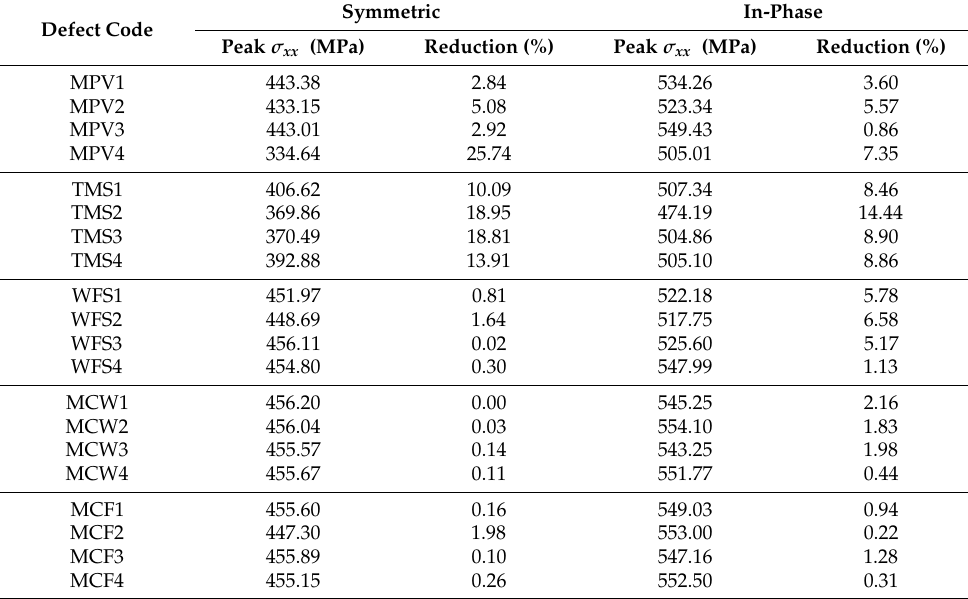
Figure 18. Effect of defects on nominal stress-strain curves for in-phase unit cell: ( a ) matrix pocket void; ( b ) tow and matrix pocket separation; ( c ) warp tow and fill tow separation; ( d ) matrix direction crack in warp tow; and ( e ) matrix direction crack in fill tow. Table 4. Peak nominal stresses and their percent reduction compared to no defect cases for symmetric and in-phase plain weave unit